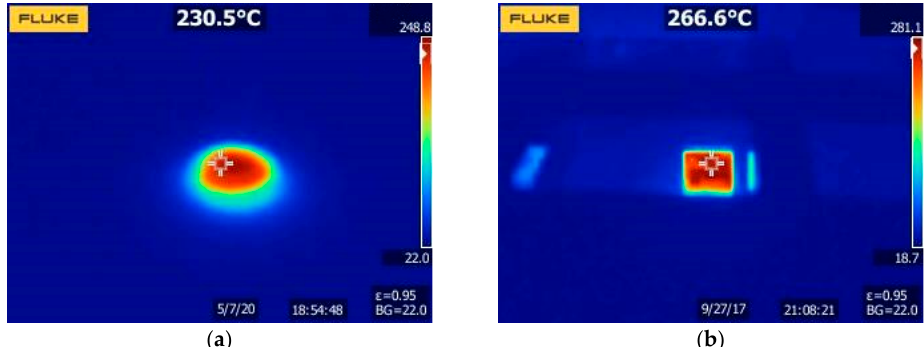
Figure 1. Thermal equilibrium temperature of different metal foreign objects placed on the surface of 6.6 kW transmitter coil: ( a ) 1-yuan RMB coin; ( b ) Iron sheet.